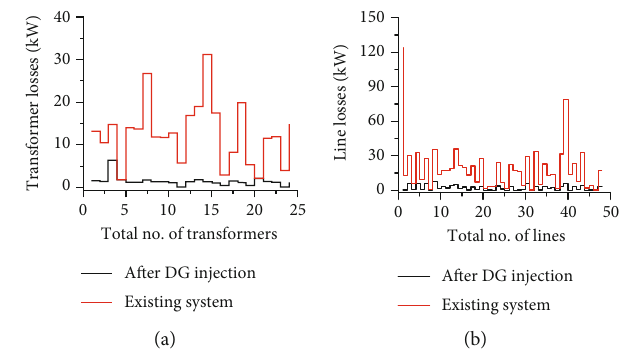
Figure 22: (a) Transformer losses and (b) line losses before and after DG in zone C.